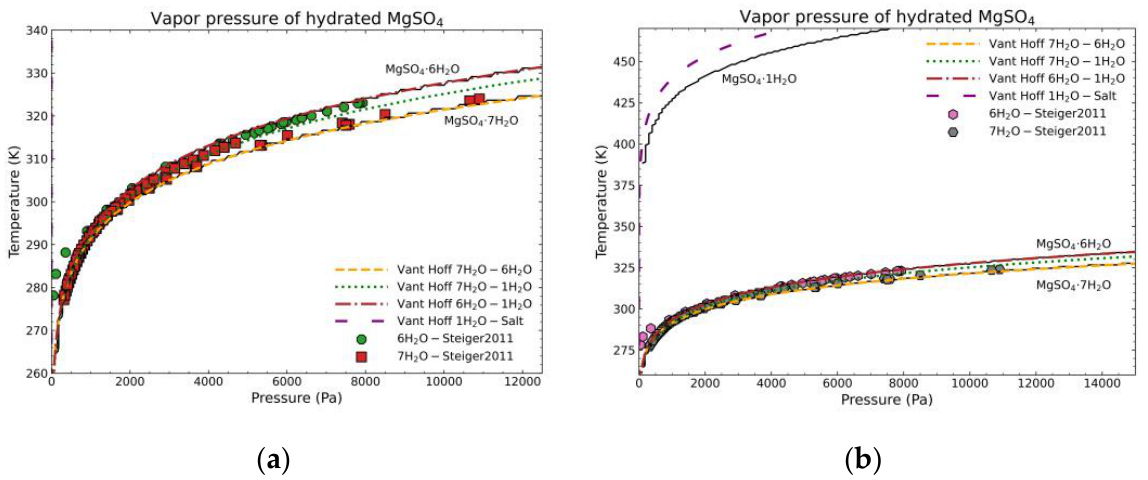
Figure 19. Temperature—vapor pressure comparison of MgSO 4 · 7H 2 O between experimental data from Steiger et al. [37], Van’t Hoff curves, and the calculation of this work taking the MgSO 4 · 7H 2 O as the fixed composition (black lines): ( a ) for a limited range to show literature points for the dehydration of MgSO 4 · 7H 2 O and MgSO 4 · 6H 2 O; ( b ) extended range to show further curves and the dehydration of MgSO 4 · 1H 2 O.